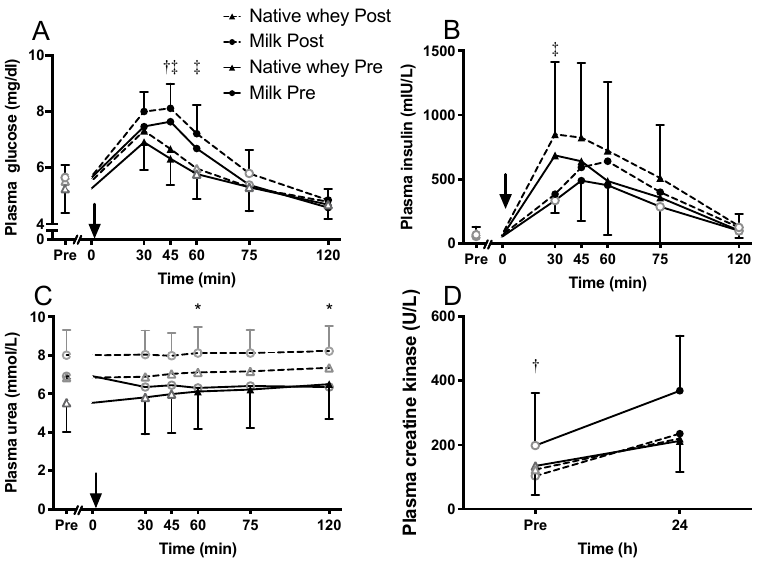
Figure 4. Changes in serum glucose ( A ), insulin ( B ), urea ( C ), and creatine kinase ( D ) following intake of milk or native whey immediately after a bout of resistance exercise in the elderly. Arrow indicates time point of protein supplement ingestion. Values are mean ± SD (only shown for highest and lowest values). n = 9 and 11 in the milk and native whey group, respectively. Data were analyzed with a two-way repeated measures ANOVA (time × supplement). Multiple comparisons tests were used as post-hoc tests to specify the significant di ff erences between groups (Tukey) and within groups and training states (Dunett). Black data points indicate a di ff erence form resting values; gray hollow data points indicate no significant di ff erence from resting levels. * milk di ff erence between pre and post, † milk and native whey di ff erent at pre, ‡ milk and native whey di ff erent at post, p < 0.05.